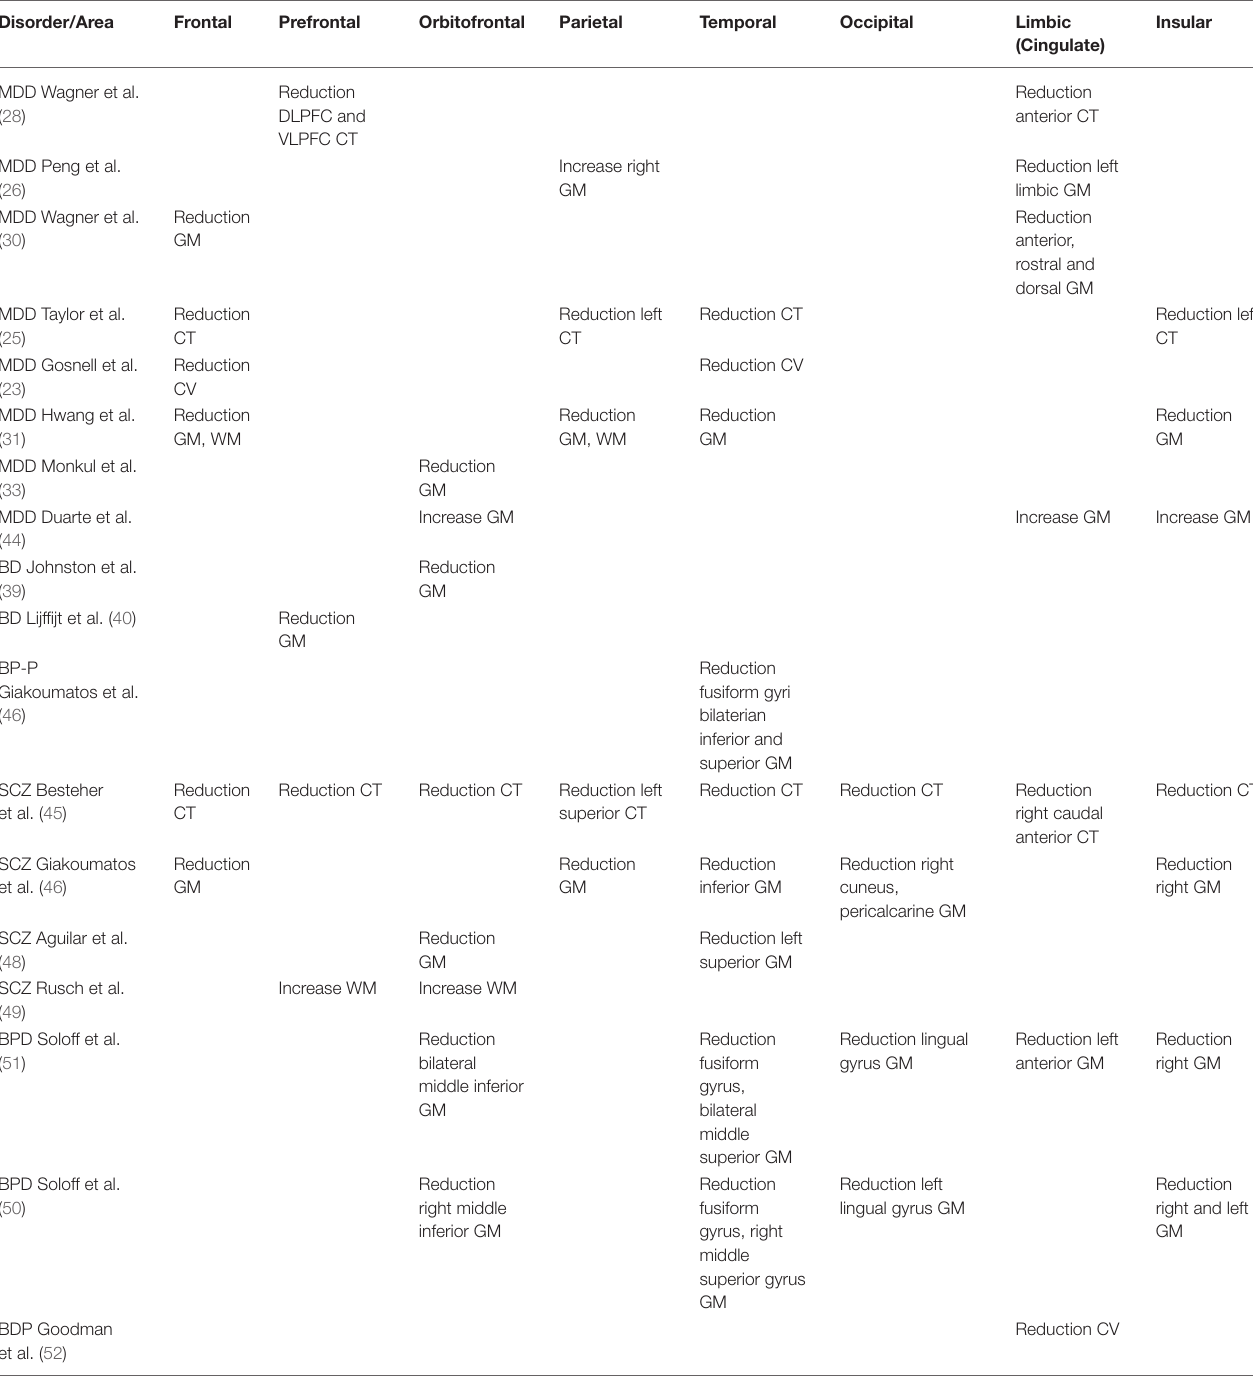
TABLE 7 | Cortical phenotypes associated with SB across disorders.